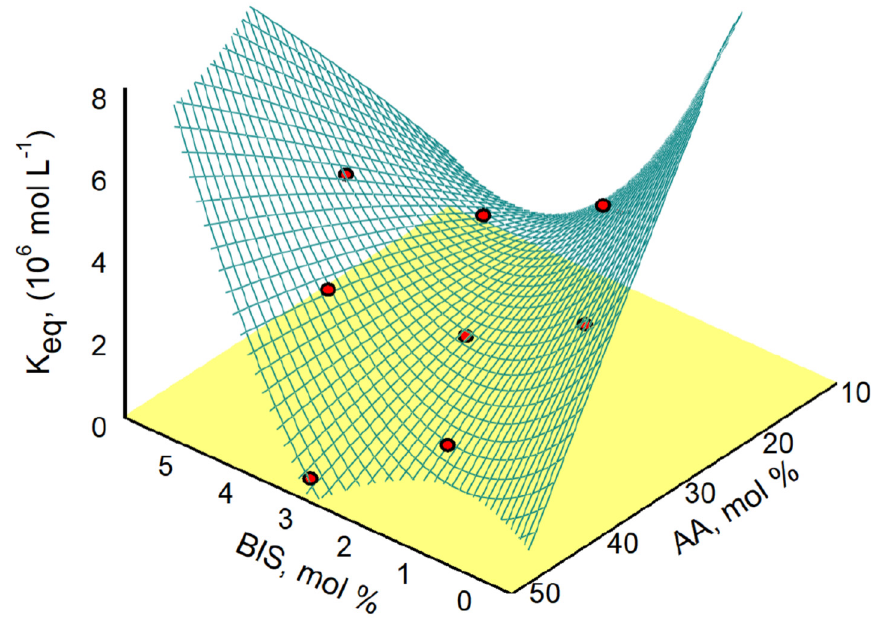
Figure 1. Responding surface of the two-factor central composite design. Red dots: experimental points.